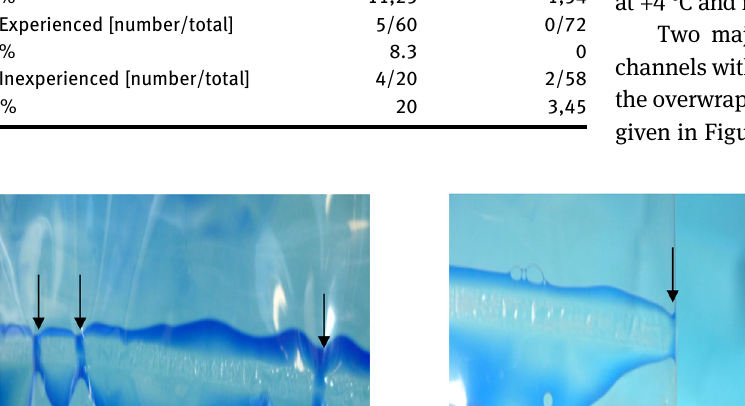
Figure 2: Visual observation of defect seals when using S422VM heat